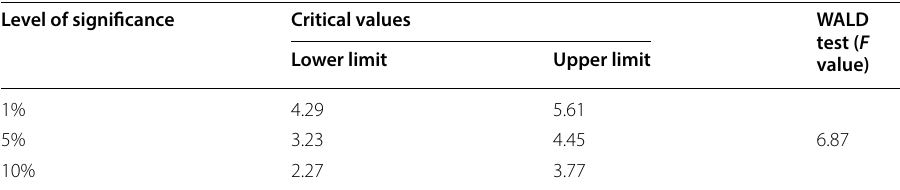
Critical values (lower and upper values) for the bounds test; case D: (restricted intercept and no trend) Narayan (2005) The results of Wald F- test statistics along with critical values are (upper and lower values) reported in Table 6, and these information is supported from Narayan (2004). The results of Wald F- test is 6.87 at lag 2, which is greater than the upper and lower bond critical values at 1%, 5% and 10% level of significance. Therefore, results showed that our all variables are co-integrated